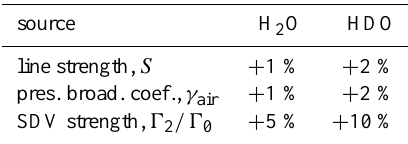
Table 1. Statistics of DOFs for cloud free IASI retrievals over the subtropical northern Atlantic (number of observations: 72).